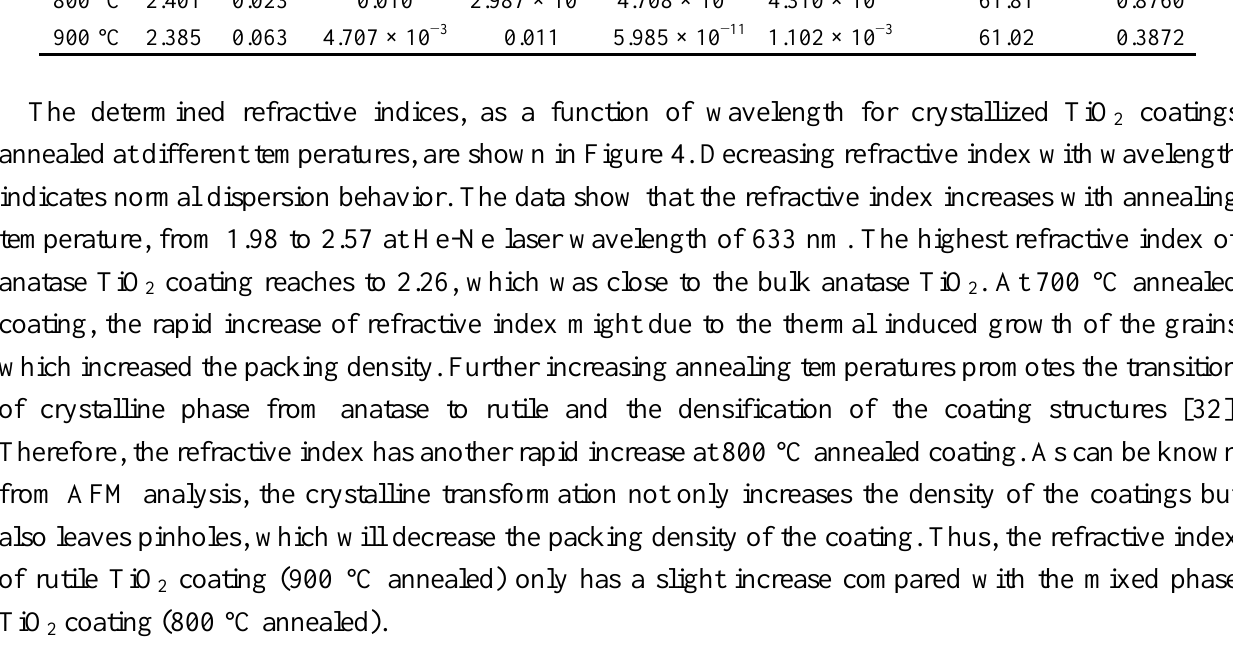
Figure 4. Refractive index dispersion of TiO